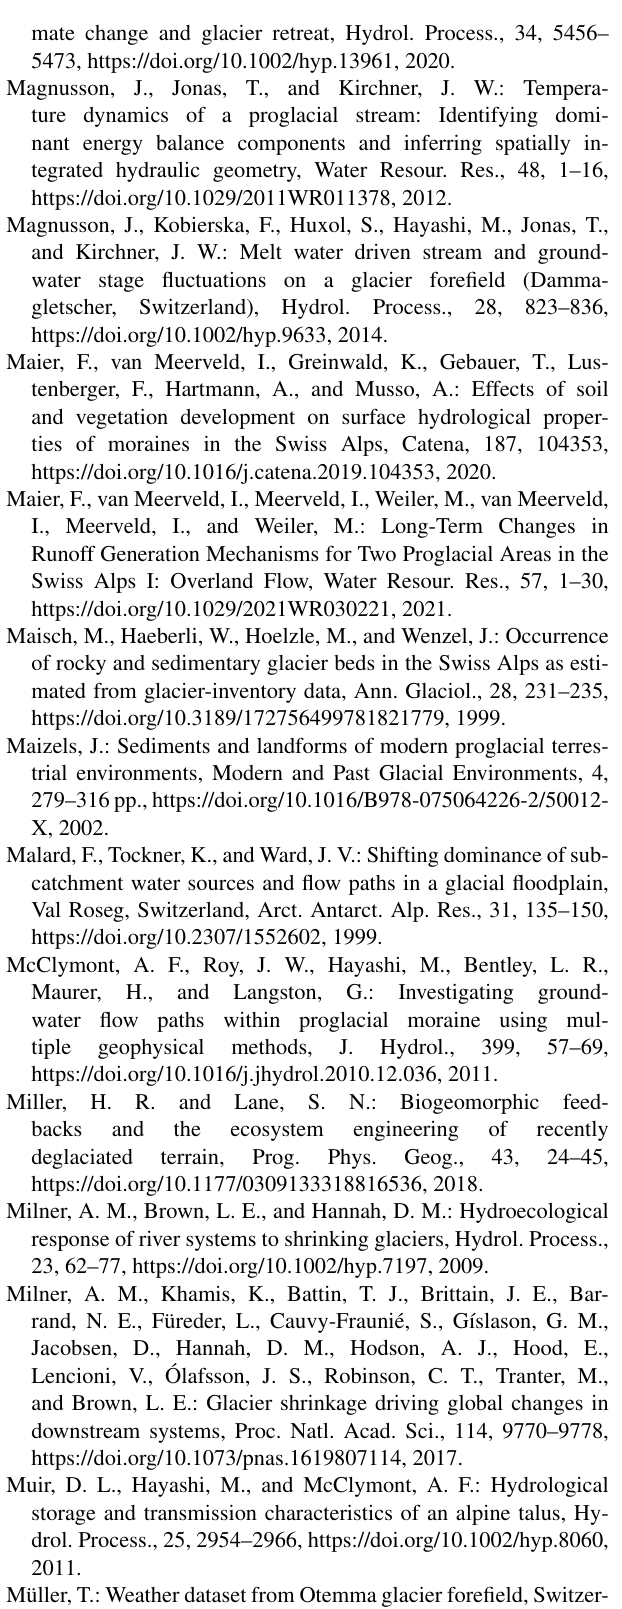
Müller, T.: Water table elevation and groundwater temperature